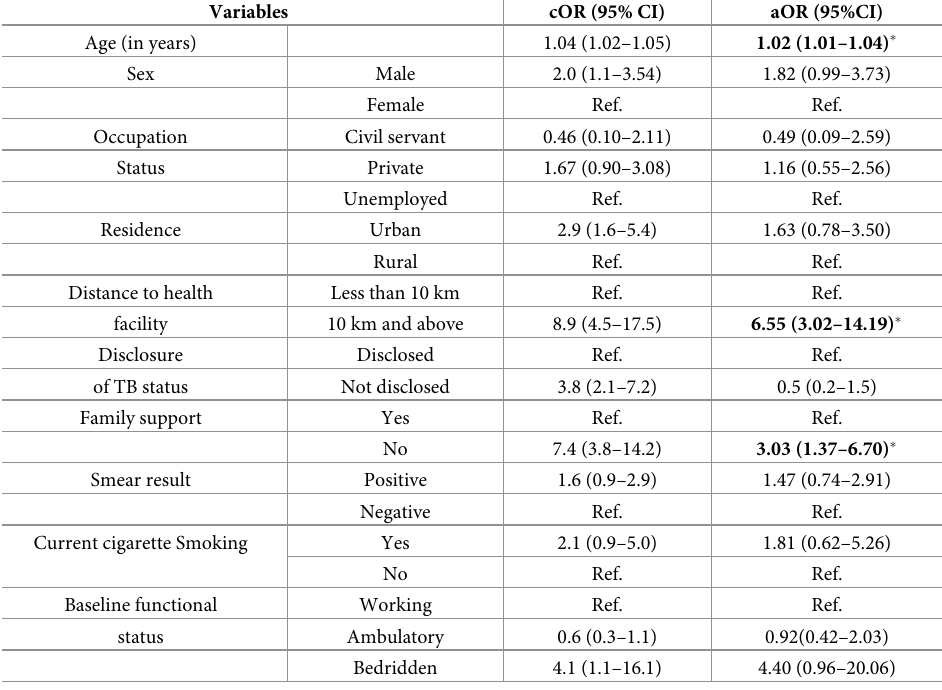
Table 3. Factors associated with poor treatment outcomes of tuberculosis among adult patients registered at Gibe Woreda public health facilities, Hadiya zone, Southern Ethiopia from 1 st January 2017 to 31 st December